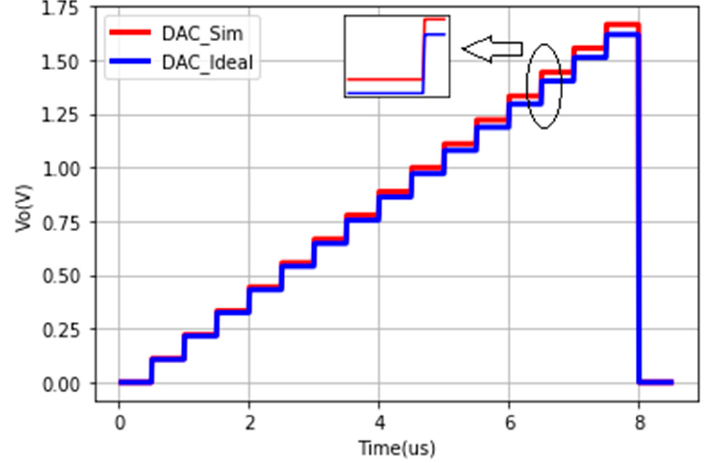
Figure 14. Simulation of a 4 bit binary-weighted DAC cell.